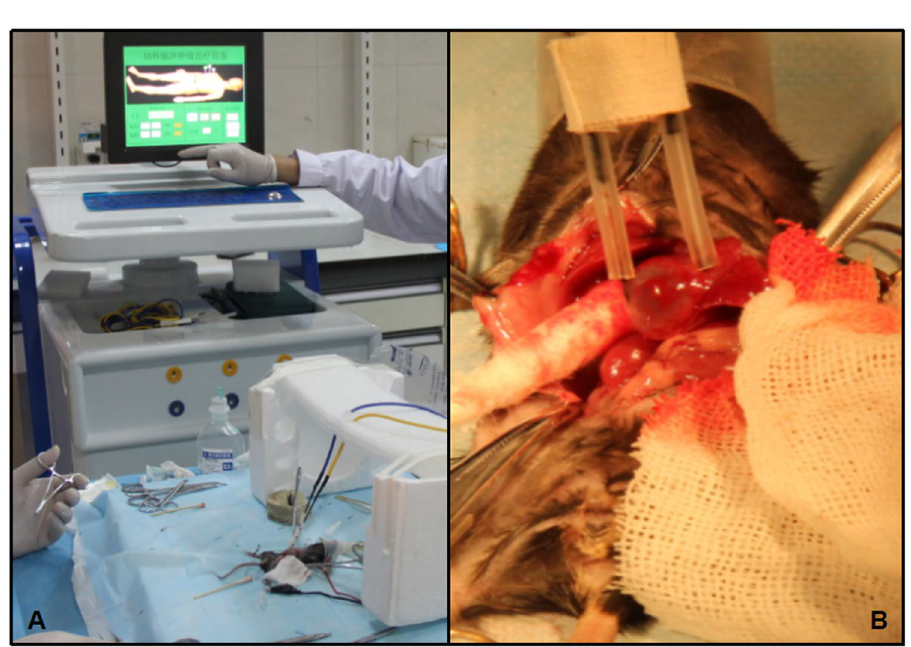
Figure 2. The nsPEF instrument and ablation electrodes. The nsPEF generator (Fig. 2A) and electrode (Fig. 2B) were applied on C57/B6 mice with parasite cyst in